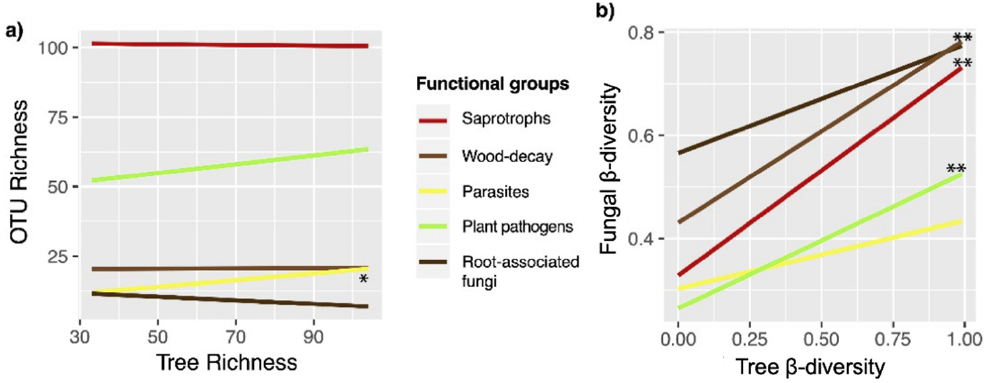
Figure 3. ( a ) Correlation between fungal OTU richness and tree richness ( b ) correlation between fungal β -diversity and Figure 3. (a) Correlation between fungal OTU richness and tree richness (b) correlation between tree β -diversity across primary and regenerating secondary forest sites in Costa Rica. Significance levels of correlation are: fungal β -diversity and tree β -diversity across primary and regenerating secondary forest sites in * = p ≤ 0.05 and ** = p ≤ Costa Rica. Significance levels of correlation are: * = p ≤ 0.05 and ** = p ≤ 0.01.